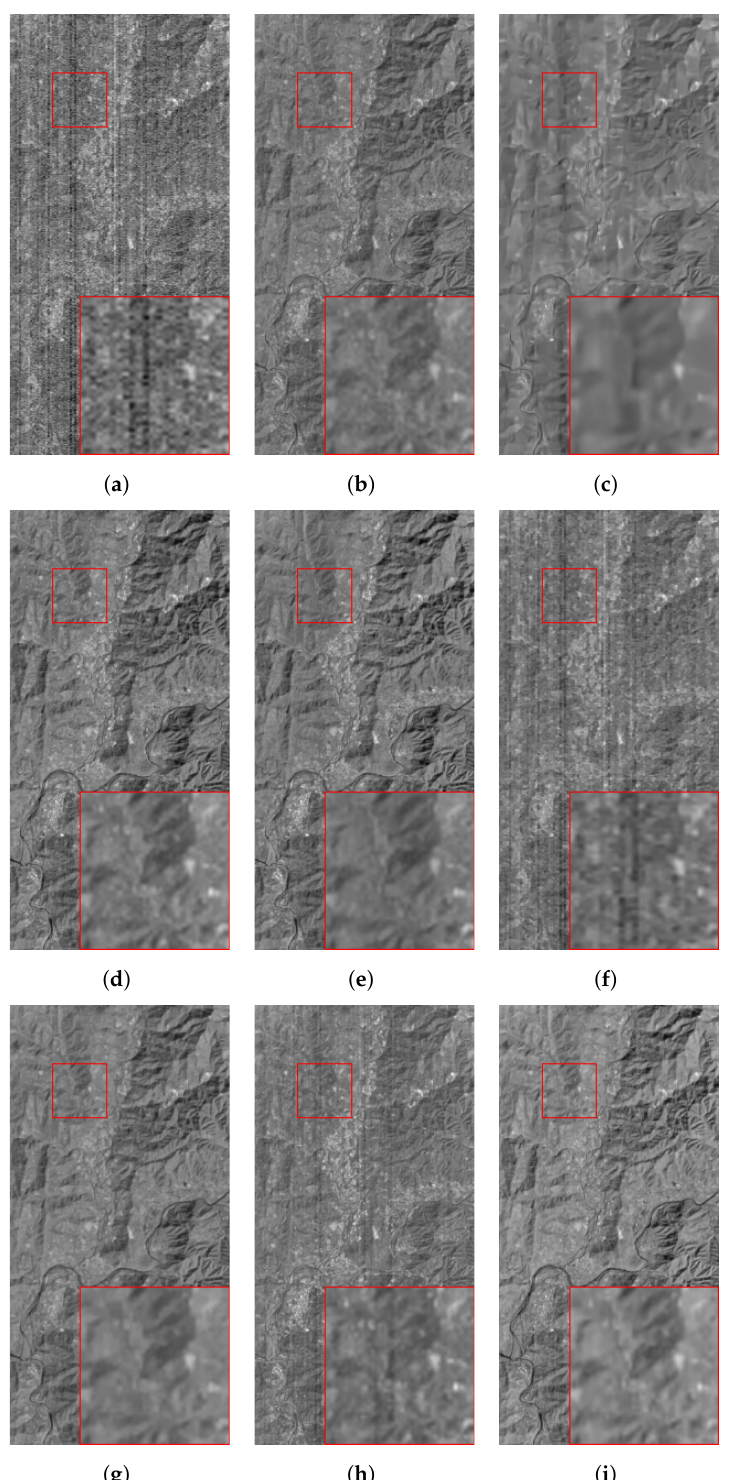
Figure 16. Real-data experiment of HSI denoising results compared with existing methods on the EO-1 Hyperion dataset: (a) original image of band 36; ( b ) NNM; ( c ) BM4D; ( d ) WNNM; ( e ) WSNM; ( f ) LRTDTV; ( g ) 3DTV; ( h ) FastHyDe; and ( i ) the proposed